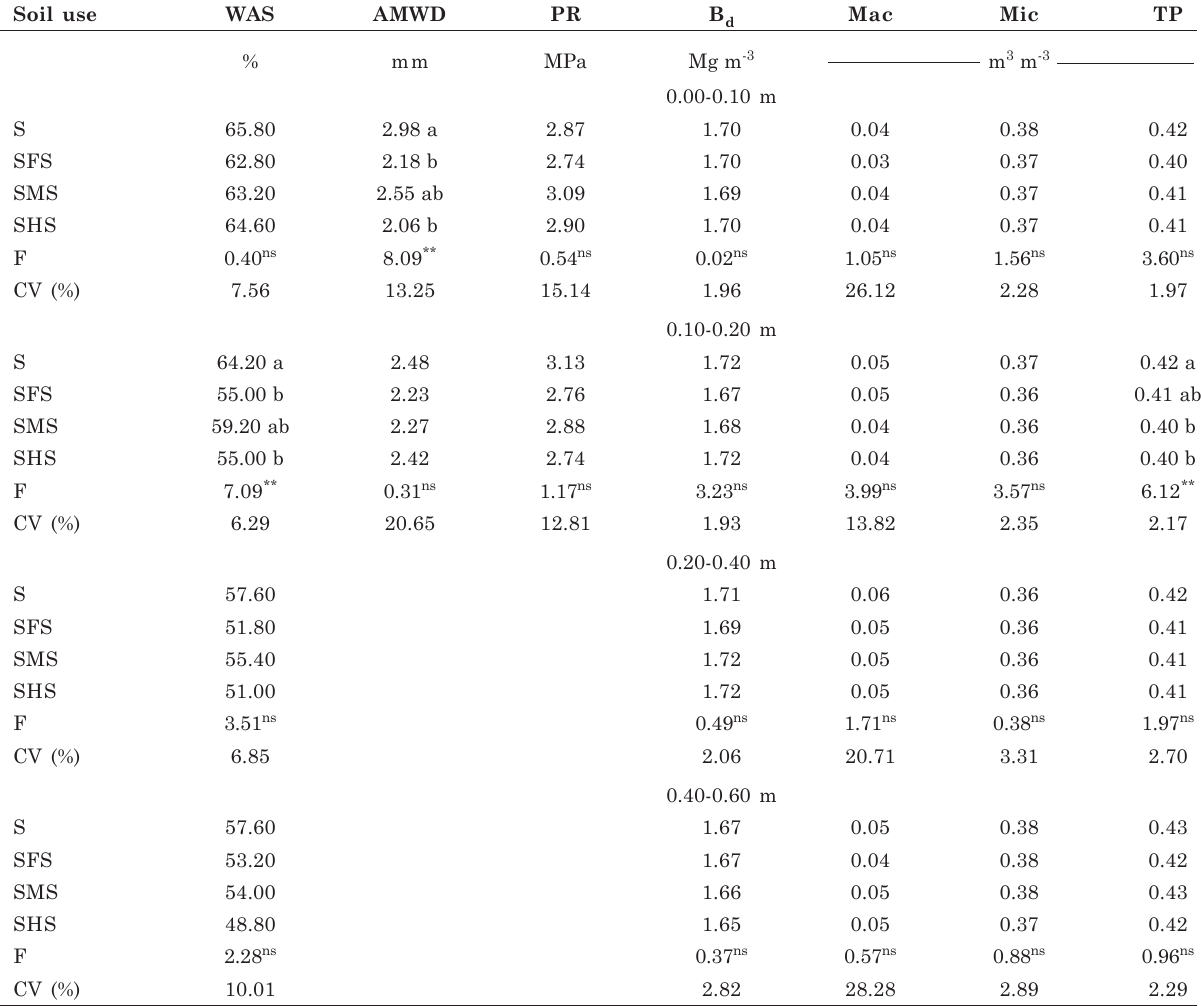
Table 4. Water stability of soil aggregates (WAS), aggregate mean weight diameter (AMWD),